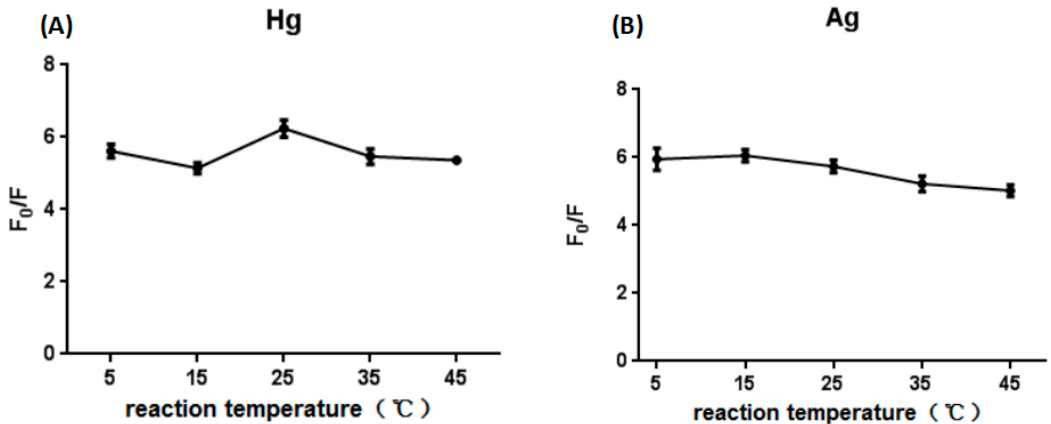
Figure 4. Optimization of the reaction temperature in the presence of Hg 2+ ( A ). Optimization of the reaction temperature in the presence of Ag + ( B ).